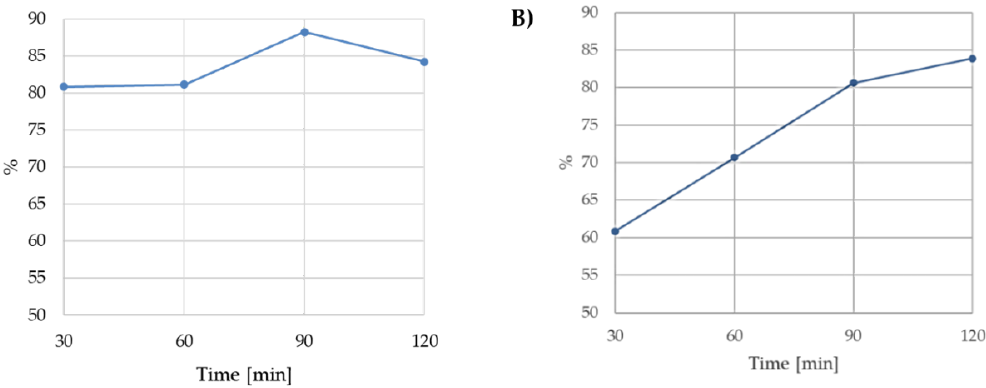
Figure 3. ( A ) Conversion trend for reaction with CNS-Cu; ( B ) conversion trend for the reaction with CNS-Zn.